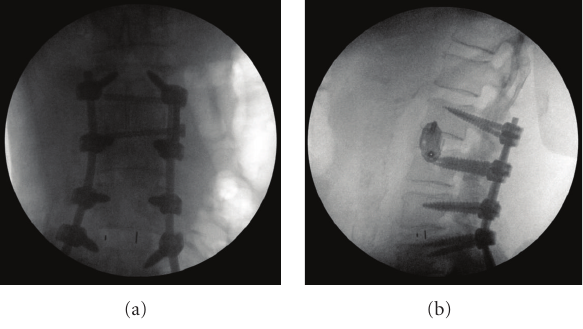
Figure 2: Intraoperative AP and lateral images showing L2- L3 interbody fusion and lateral plate fixation using the lateral transpsoas approach for